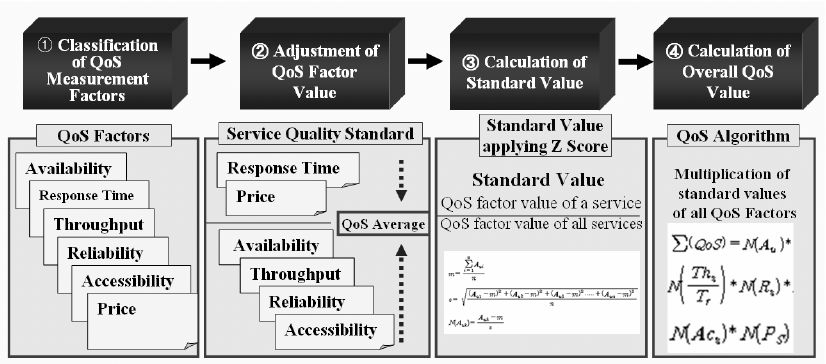
Figure 2. QoS Measurement